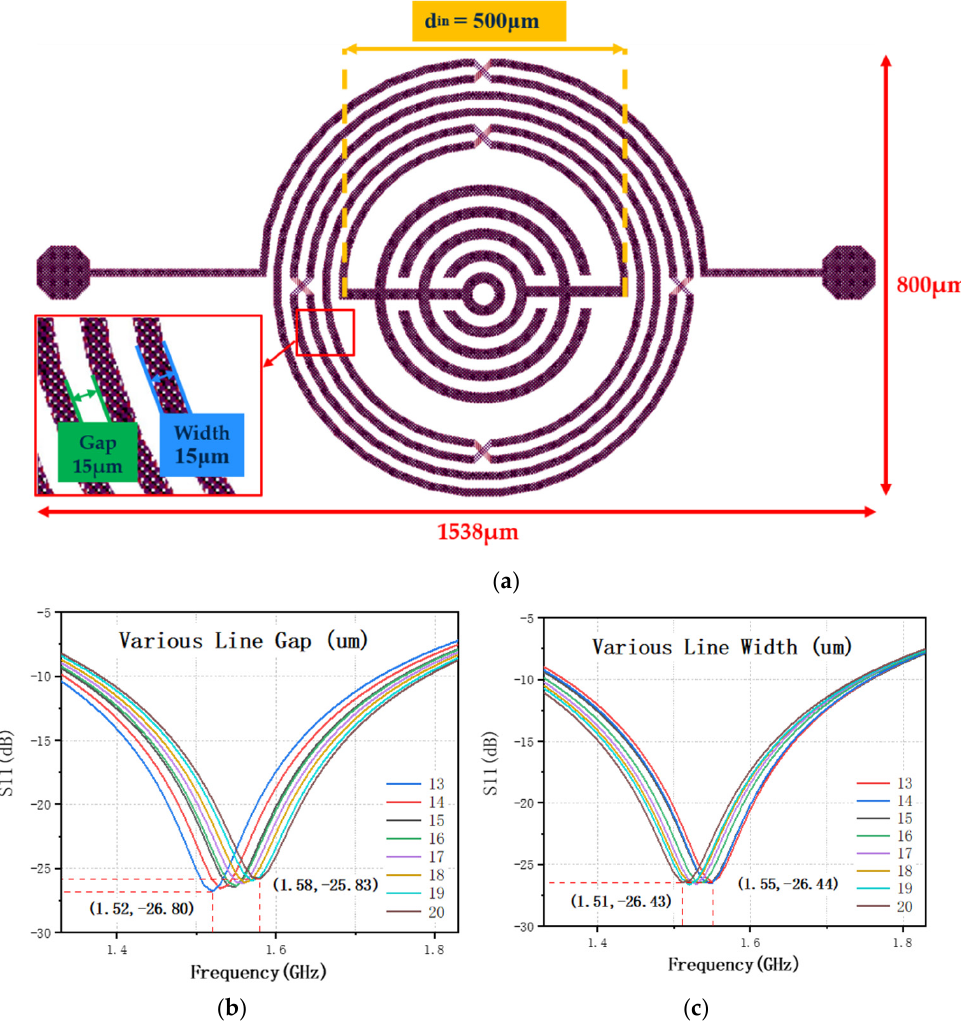
Figure 2. Simulation results on the influence of the two parameters on the S-parameter and center frequency: ( a ) top view of the proposed IPD BPF layout with the markers of metal line width and gap; ( b ) simulation results with different line widths; ( c ) simulation results with different line gaps. Table 1. Dimensional information of the proposed IPD BPF line gap adjustment.